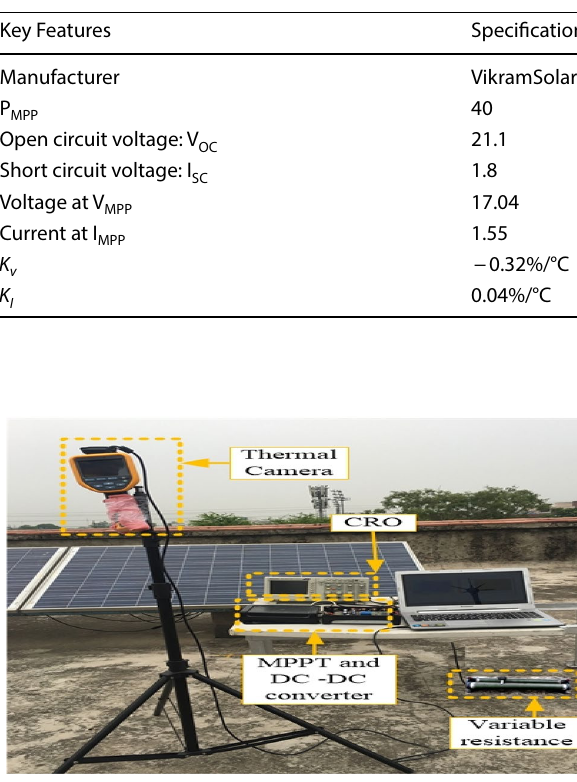
Table 2 Specifications of PV module used